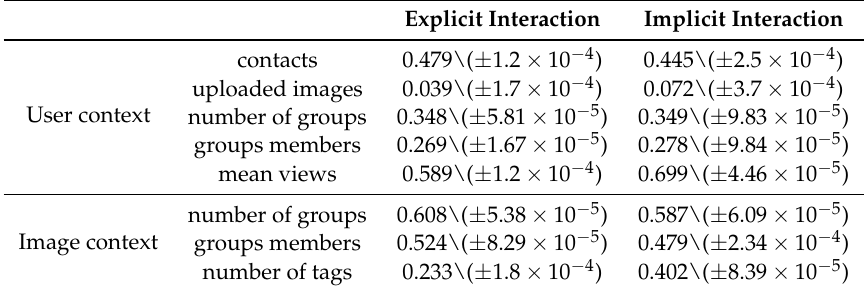
Table 3. Average and variance of correlation between social factors and social interactions on the 10 random